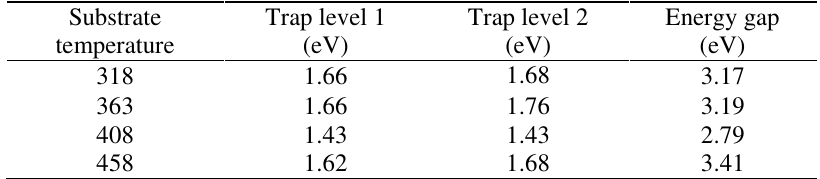
Table 1. The optical band gap energies of Nickel phthalocyanine thin films of thickness 400nm deposited at different substrate